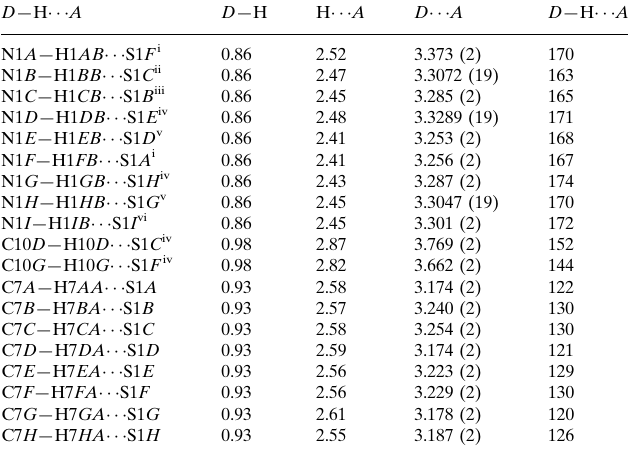
Hydrogen-bond geometry (A˚ , (cid:2) ). D —H (cid:3)(cid:3)(cid:3)